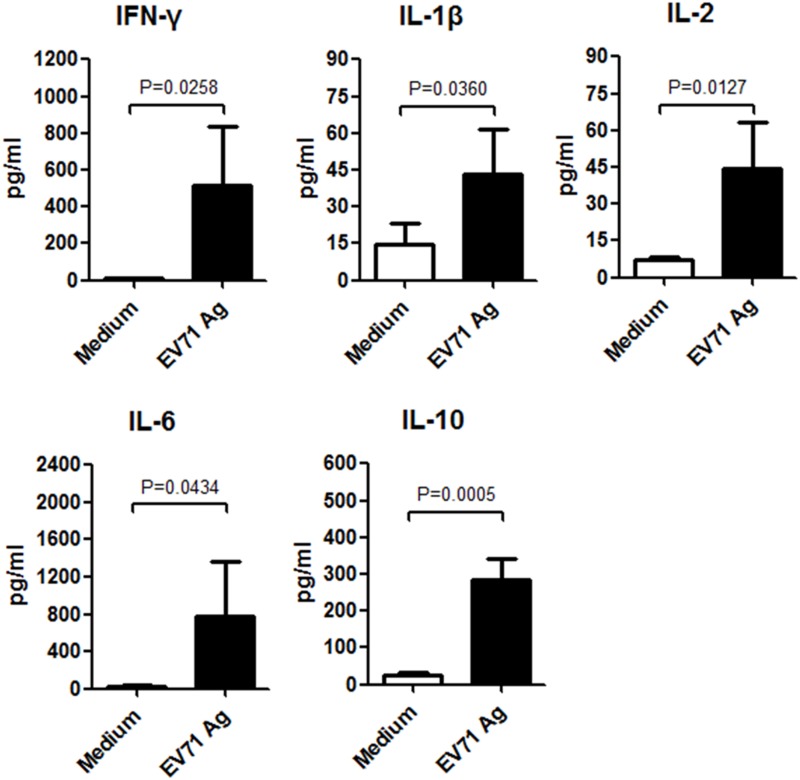
Secretion of cytokines in culture supernatants of spleen lymphocytes after stimulation with EV71 inactivated liquid bulk.Spleen lymphocytes from C57BL/6 mice (n = 5 per group) were co-incubated with EV71 inactivated liquid bulk (100U/ml) for 48h. Untreated samples were used to determine the background of secretion of cytokines. Suspension was then centrifuged, and cytokines in the cell-free supernatants were tested by luminex method. Five cytokines (IL-1β, IL2, IL6, IL-10 and IFN-γ) were found to be significantly up-regulated after incubation.